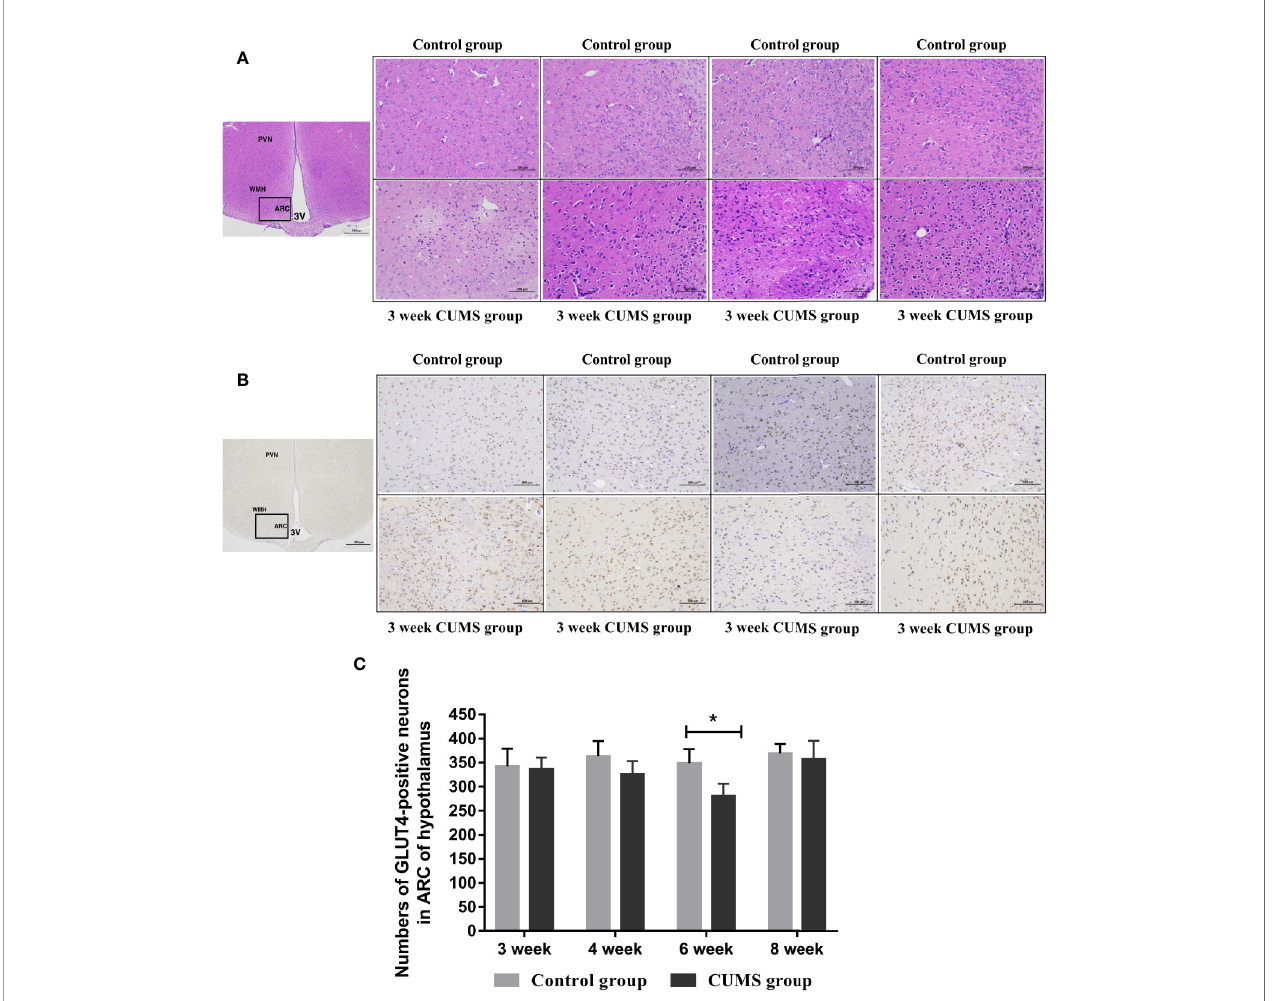
FIGURE 5 | The in fl uence of CUMS on histomorphology and GLUT4-postive neurons in hypothalamus of rats. (A) Representative micrographs of neurons in hypothalamus. (B) Representative micrographs of immunohistochemical staining for the GLUT4 proteins in the hypothalamus. The fi rst micrographs was captured at low magni fi cation (scale bar = 500 m m, 40x magni fi cation); the remaining micrographs were captured at higher magni fi cation (scale bar = 100 m m, 200x magni fi cation), and observed the ARC of hypothalamus. (C) Quantitative analysis of the numbers of GLUT4-poistive neurons in the ARC of hypothalamus. PVN, paraventricular nucleus; VMH, ventromedialnucleus; ARC, arcuate nucleus; 3V, third ventricle. Data are presented as mean ± SD, n = 4 in immunohistochemical analysis; *p < 0.05 vs. Control